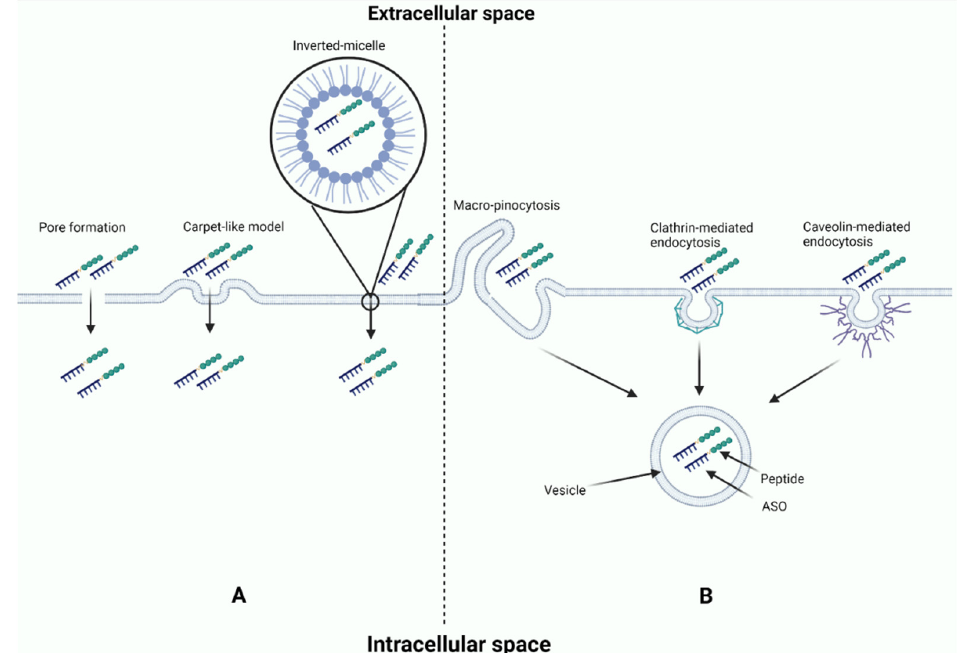
Figure 5. ( A ) Membrane transduction is an energy-independent pathway to deliver cell-penetrating peptides (CPPs) and their cargo into the cells via the interaction between positively charged CPPs and negatively charged phospholipids of cell membrane. This interaction forms transient structures including pores, carpet-like structures caused by destabilizing cell membrane, or inverted micelles that facilitate delivery. ( B ) Endocytic internalization is an energy-dependent pathway and is mostly directed toward macropinocytosis, clathrin-mediated, caveolin-mediated, or clathrin/caveolin-in- dependent (not shown in this figure) pathway. “Schematic diagram created with premade icons and templates from biorender.com (accessed on 20 August 2022).”